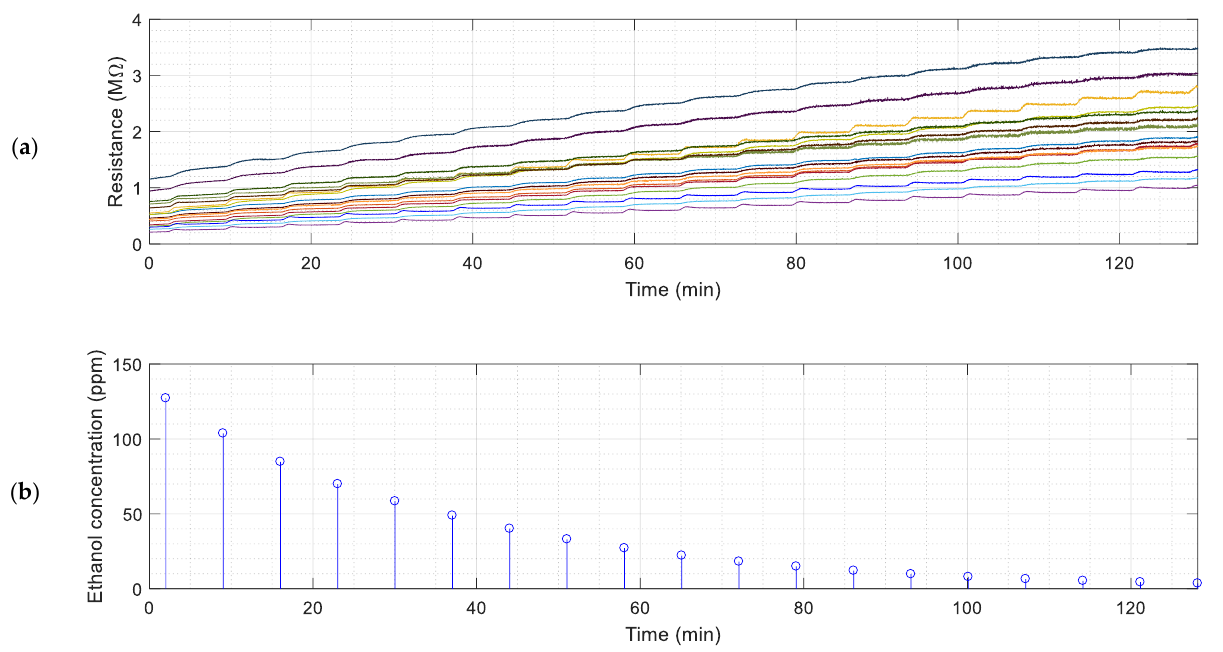
Figure 3. Result of an eNose calibration experiment with ethanol: ( a ) evolution of resistance of the sensing layer of 16 MOX gas sensors embedded in the 16 BME680 sensors, and ( b ) reference ethanol concentration measured with the PID (assumed as the ground truth concentration).